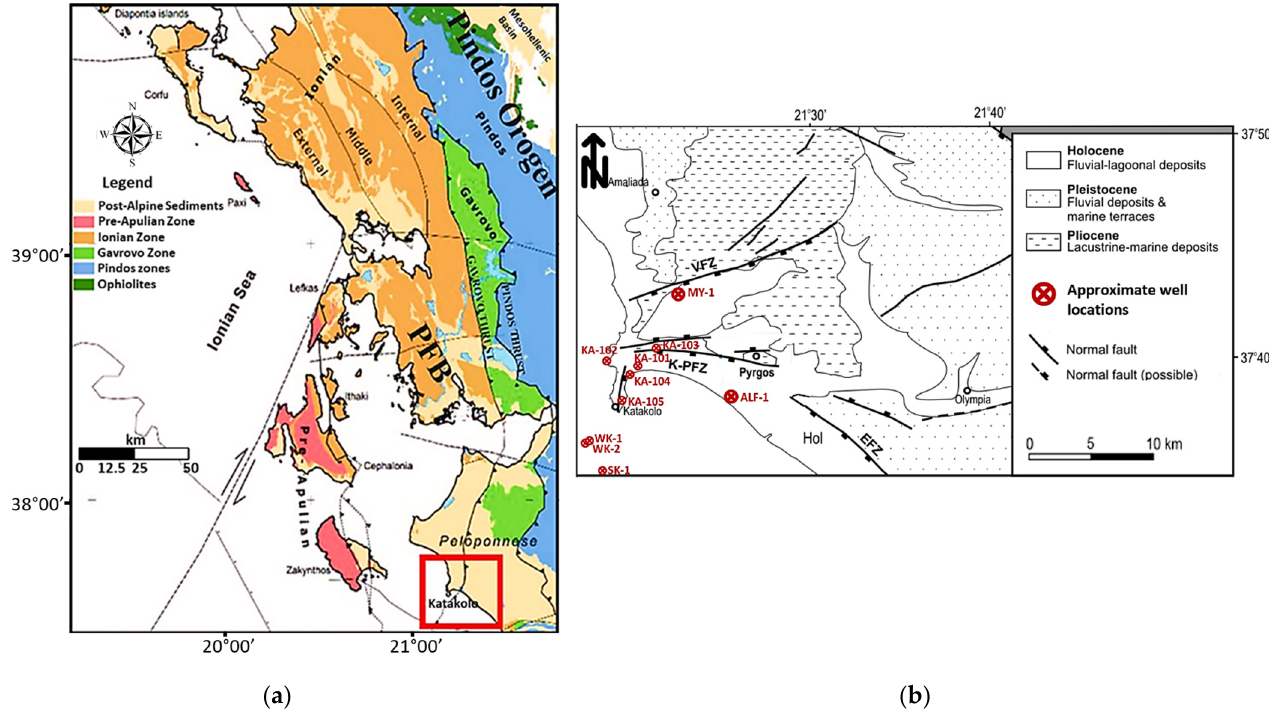
Figure 1. ( a ) Location of Katakolo within the External Hellenides with the area of interest delineated within a red rectangle, modified after [11]. ( b ) Main tectonic features of the onshore Katakolo area, modified after [12].